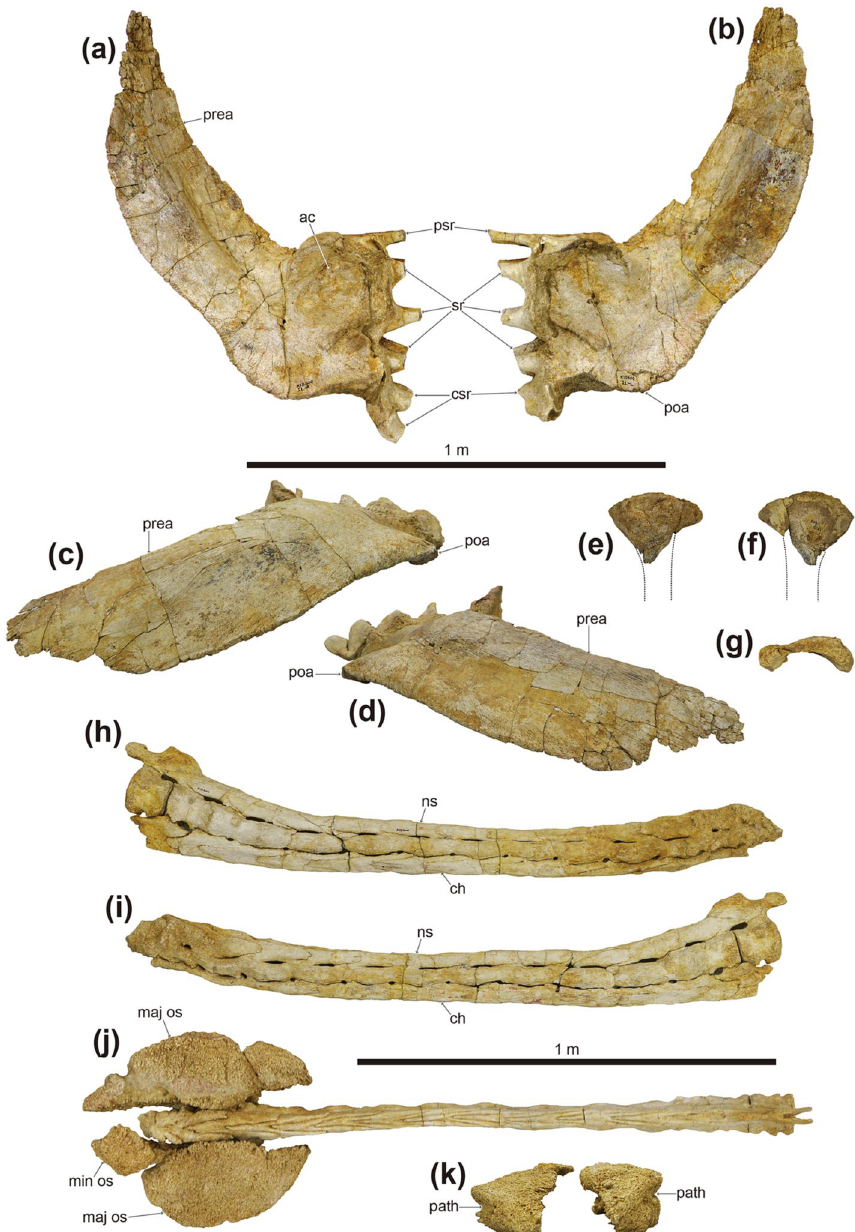
Figure 7. Photographs of both ilia ( a – d ), partial left ischium ( e – g ), and the tail club ( h – k ) of Tarchia tumanovae sp. nov. (MPC-D 100/1353). ( a ) Left and ( b ) right ilium in ventral view. ( c ) Right and ( d ) left ilium in lateral view. Left ischium in ( e ) lateral, ( f ) medial, and ( g ) proximal views. Tail club handle in ( h ) left lateral and ( i ) right lateral views. ( j ) Tail club handle and knob in dorsal view. ( k ) Tail club knob in proximal view. ac acetabulum, ch chevron, csr caudosacral rib, maj os major osteoderm, min os minor osteoderm, ns neural spine, path pathology, poa postacetabular process, prea preacetabular process, psr parasacral rib, sr sacral